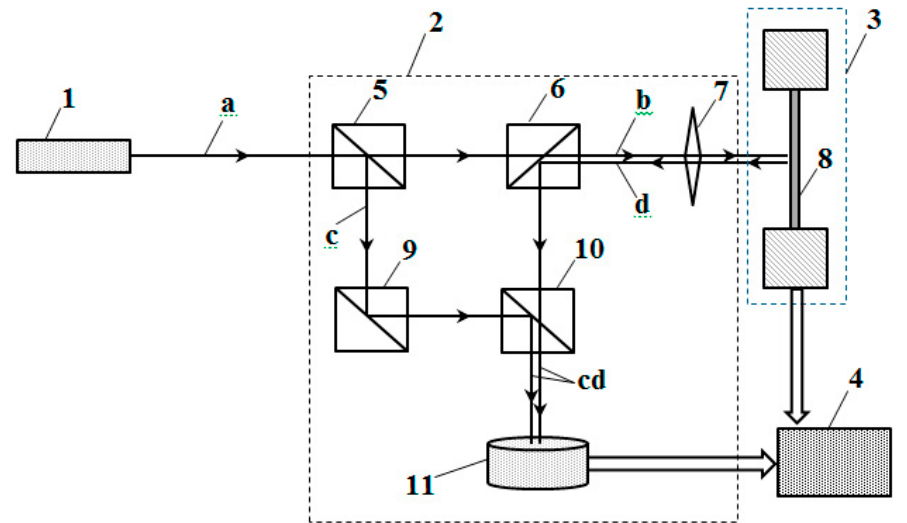
Figure 1. The structural diagram of a device for measuring the moments of occurrence of vibrational signals and their digital processing: 1—laser source, 2—interferometer, 3—loading device, 4—electronic unit for digital processing and data representation, 5, 6, 9, and 10—translucent mirrors, 7—lenses, 8—test sample, and 11—photodetector.